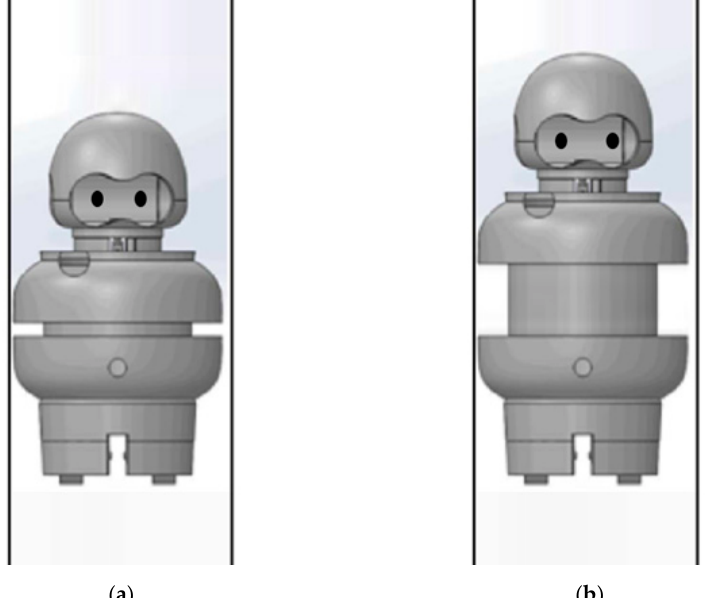
Figure 10. Robot growth: ( a ) physical appearance of the robot before growth and ( b ) after growth as shown on Table 1. Table 1. Degree of robot growth over age (example). Adapted from [22].